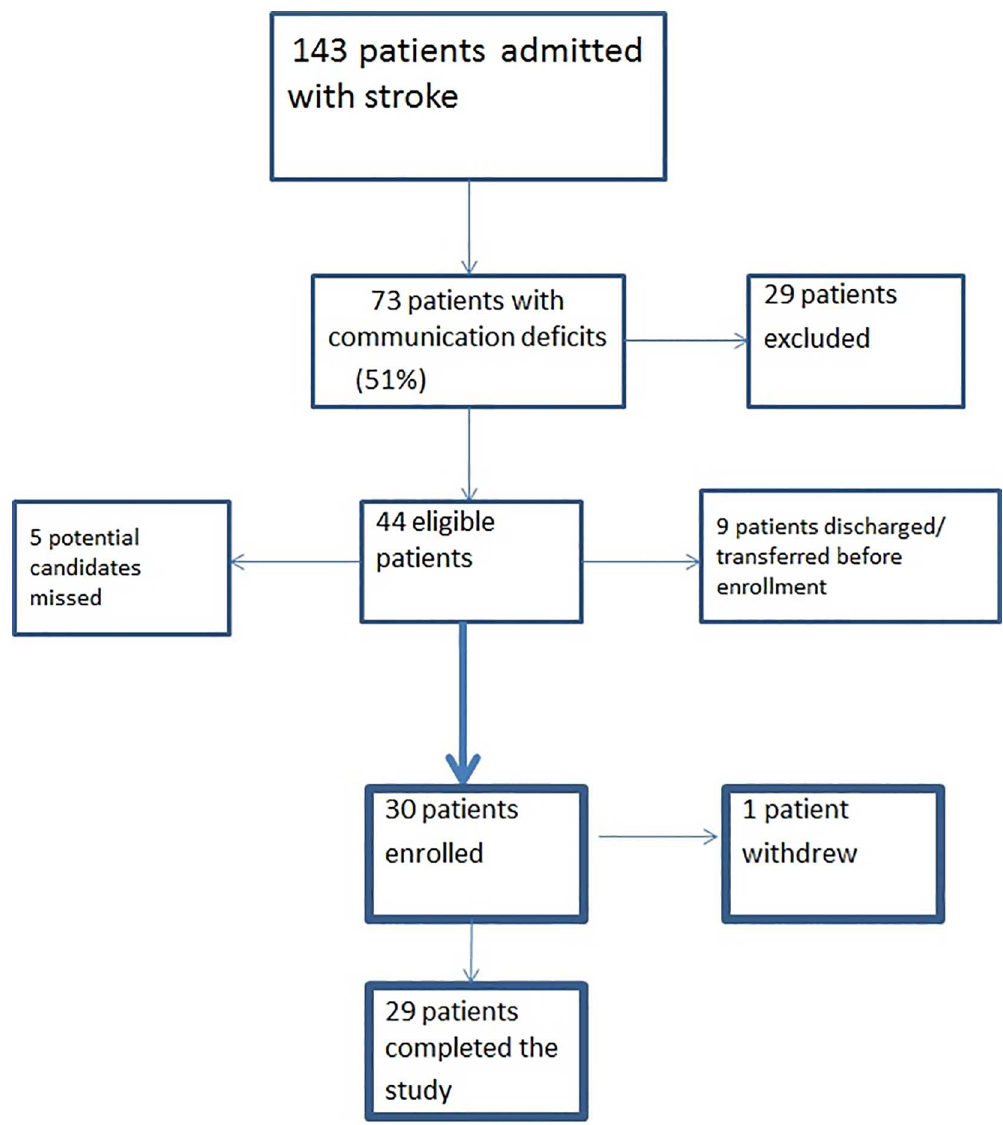
Fig 1. Flowchart of patients enrolled in the